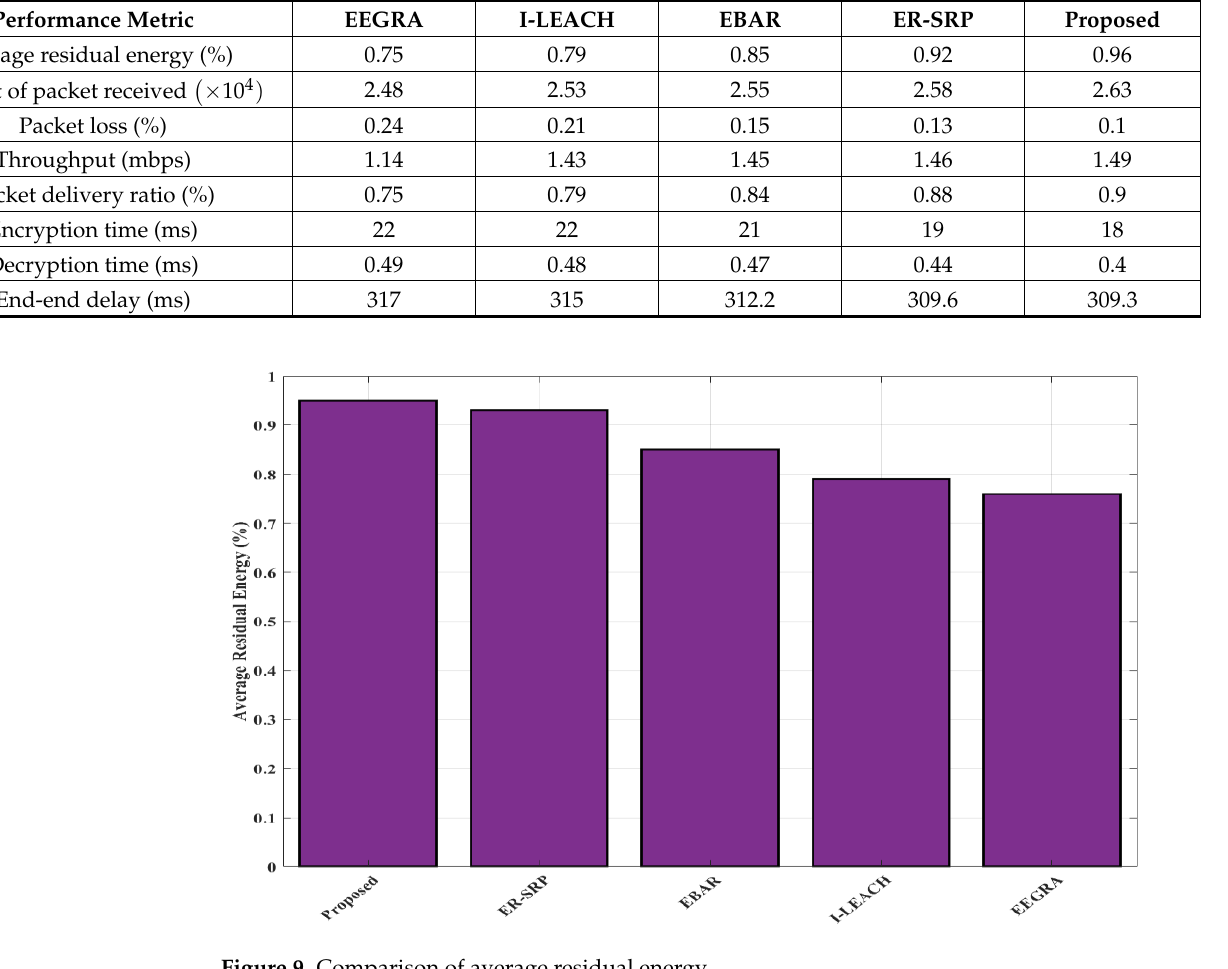
Figure 9. Comparison of average residual energy.